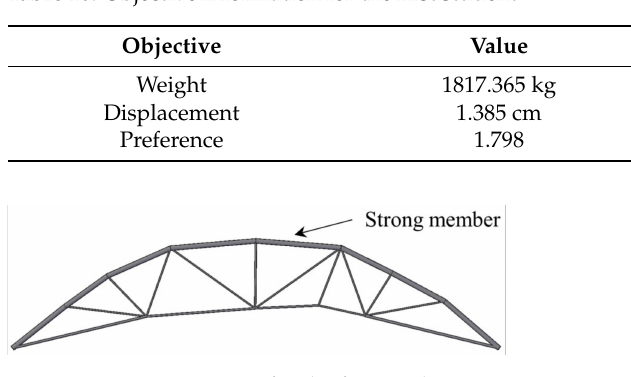
Table 10. Objective information for the first student.